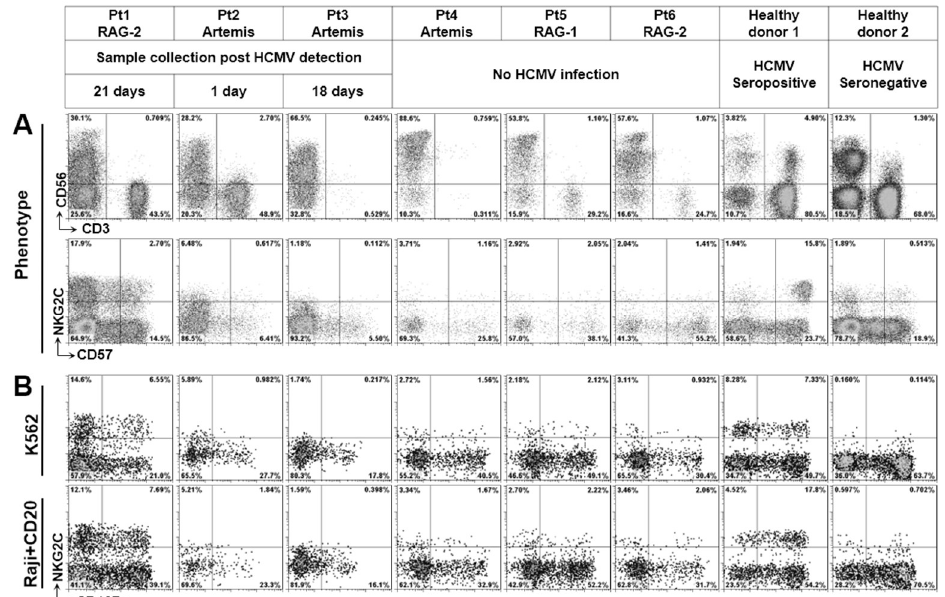
Figure 2. Phenotypic and functional characterization of RAGS − / DCLRE1C − -NK cells. ( A ) PBMCs were stained with CD3, CD56, CD57 and NKG2C. After gating on lymphocytes, CD3 and CD56 were used to identify NK cells. Then, the resulting expressions of NKG2C and CD57 on NK cells are shown. ( B ) PBMCs were cultured for 24h hours and afterwards co-cultured with K562 cells (E:T = 10:1) or Rituximab (CD20)-coated Raji cells (E:T = 10:1) for 5 h in the presence of anti-CD107a. After gating on lymphocytes, CD3 and CD56 were used to identify NK cells. Then, cell surface expression of NKG2C and CD107a on NK cells was assessed.